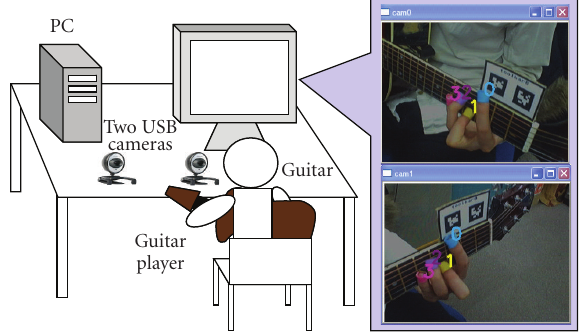
Figure 1: System